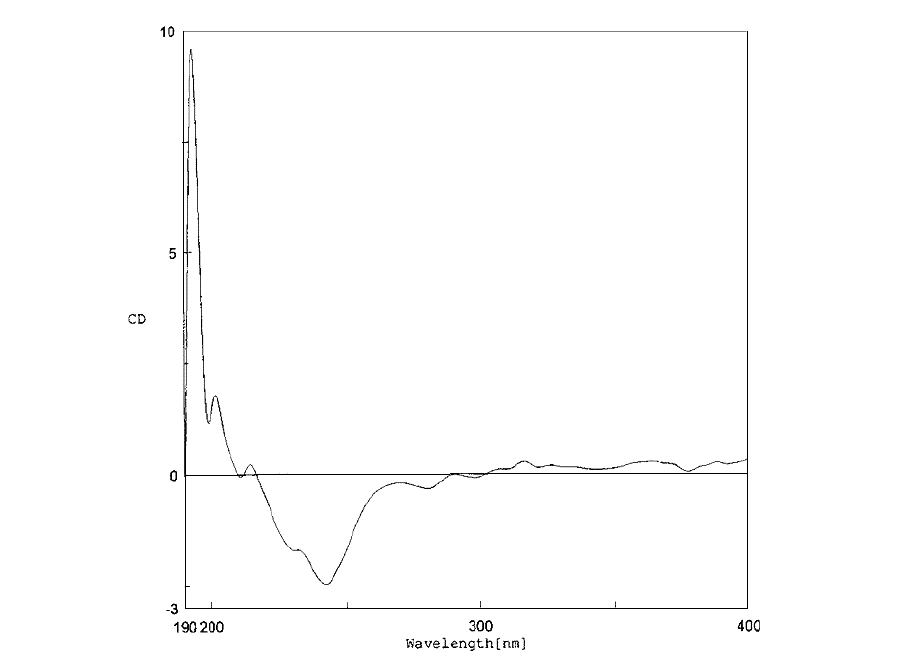
Figure 5. CD data of compound 3 .